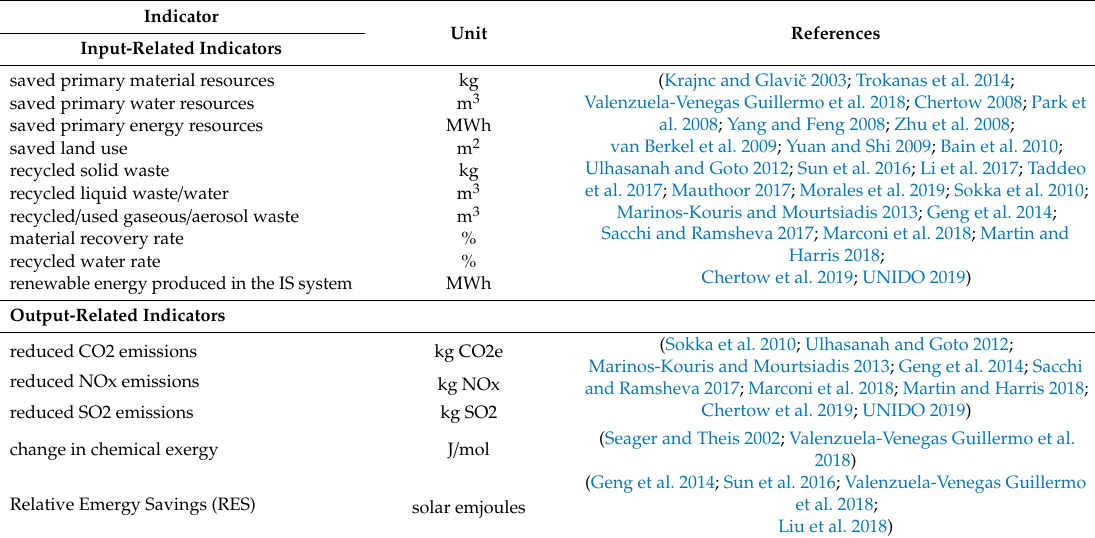
Table 4. IS environmental indicator